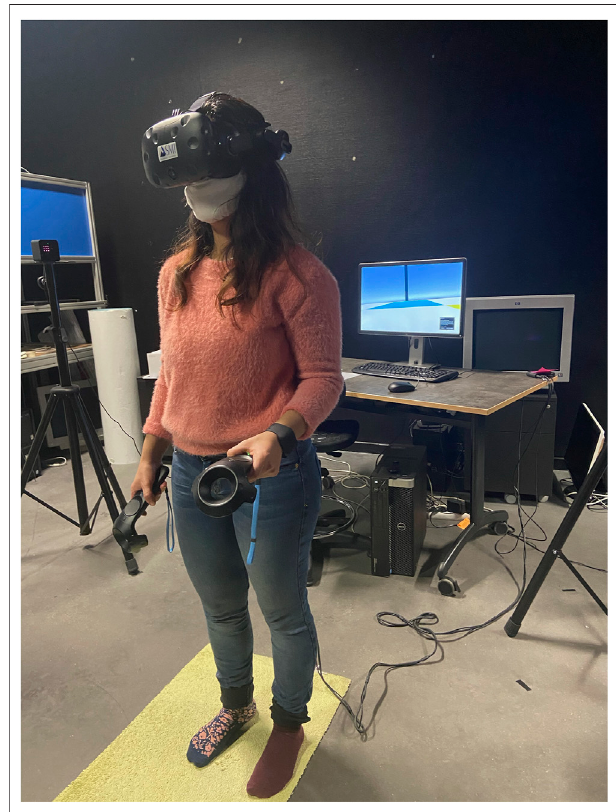
FIGURE 1| Picture ofa typical participant performing the walking on the SPOT task. Breaks were taken between trials to limit nausea as the task required continuous